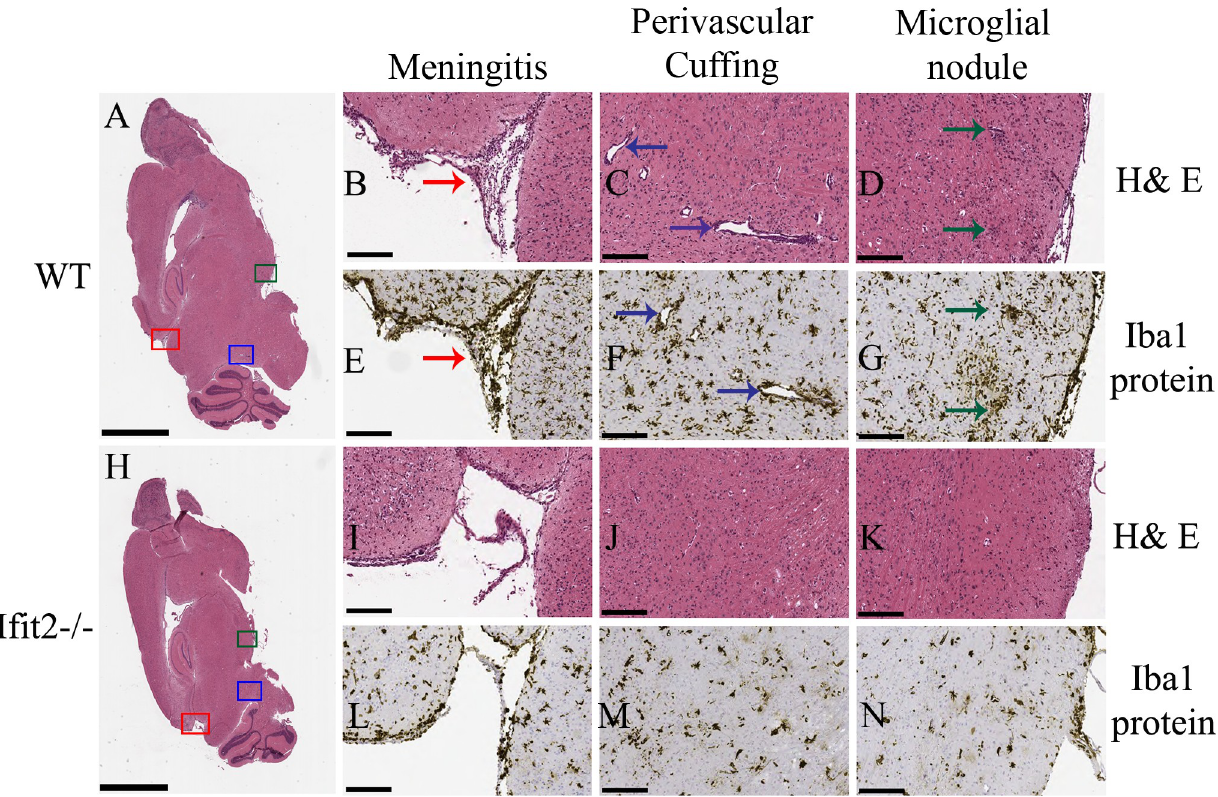
Fig 3. Ifit2 deficiency results in decreased neuroinflammation upon RSA59 infection. 5 μ m thin paraffin embedded serial sections of RSA59 infected WT and Ifit2 -/- brain tissues processed for H & E (Panels A-D and H-K) and Iba1 staining (Panels E-G and L-N) at 5 days p.i. as indicated. Representative scanned images of whole brain are shown for WT (A) and Ifit2 -/- (H) mice with selected meningeal infiltration indicated by Red box, perivascular cuffing by blue box and microglial nodule formation by green box. Selected boxed areas are enlarged for WT and Ifit2 -/- brains in Panels B, C, D and Panels I, J, K, respectively. Representative Iba1 staining in meninges, perivascular cuffs and microglial nodules is shown for WT and IFIT2 -/- brains in Panels E, F,G and L,M,N, respectively. Ifit2 -/- mice showed reduced overall inflammation, reduced or no perivascular cuffing and only scattered Iba-1+ cells without apparent nodule formation. Red arrow depicts menegitis, Dark blue arrow depicts encephalitis (perivascular cuffing), green arrow shows encephalitis (microglial nodules). The experiment was repeated three times and total n = 8. The scale bar for Panel A and H is 2 mm and for Panel B-G and Panel I-N is 75 μ